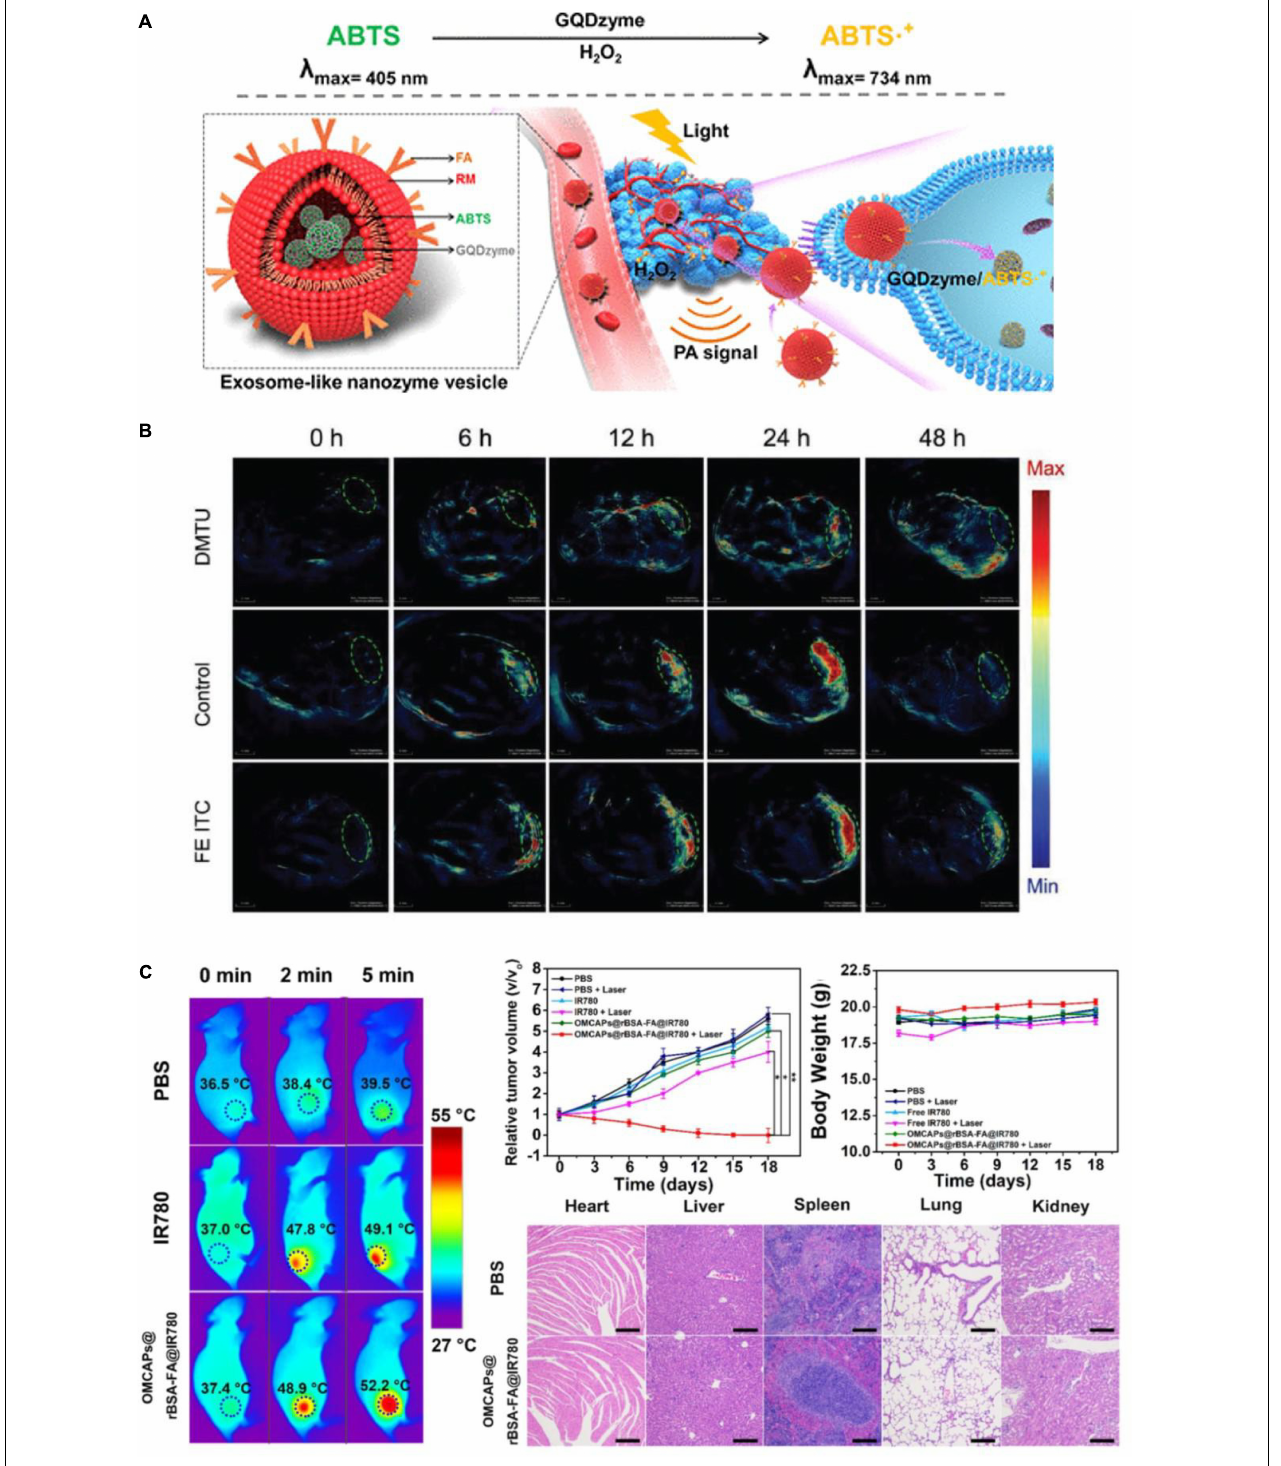
FIGURE 3 | Nanozymes for in vivo imaging of disease progression. (A) Schematic illustration of exosome-like nanozyme vesicles for the H 2 O 2 -responsive catalytic photoacoustic imaging of tumors. Reproduced with permission from ref (Ding et al., 2019), © 2019, American Chemical Society. (B) Representative nanozyme-based tumor photoacoustic imaging images. Reproduced with permission from ref (Liu F. et al., 2019), © 2019, John Wiley and Sons. (C) Carbon-gold hybrid nanozymes for real-time imaging, photothermal/photodynamic and nanozyme oxidative therapy of tumors. Reproduced with permission from ref (Zhang et al., 2019).